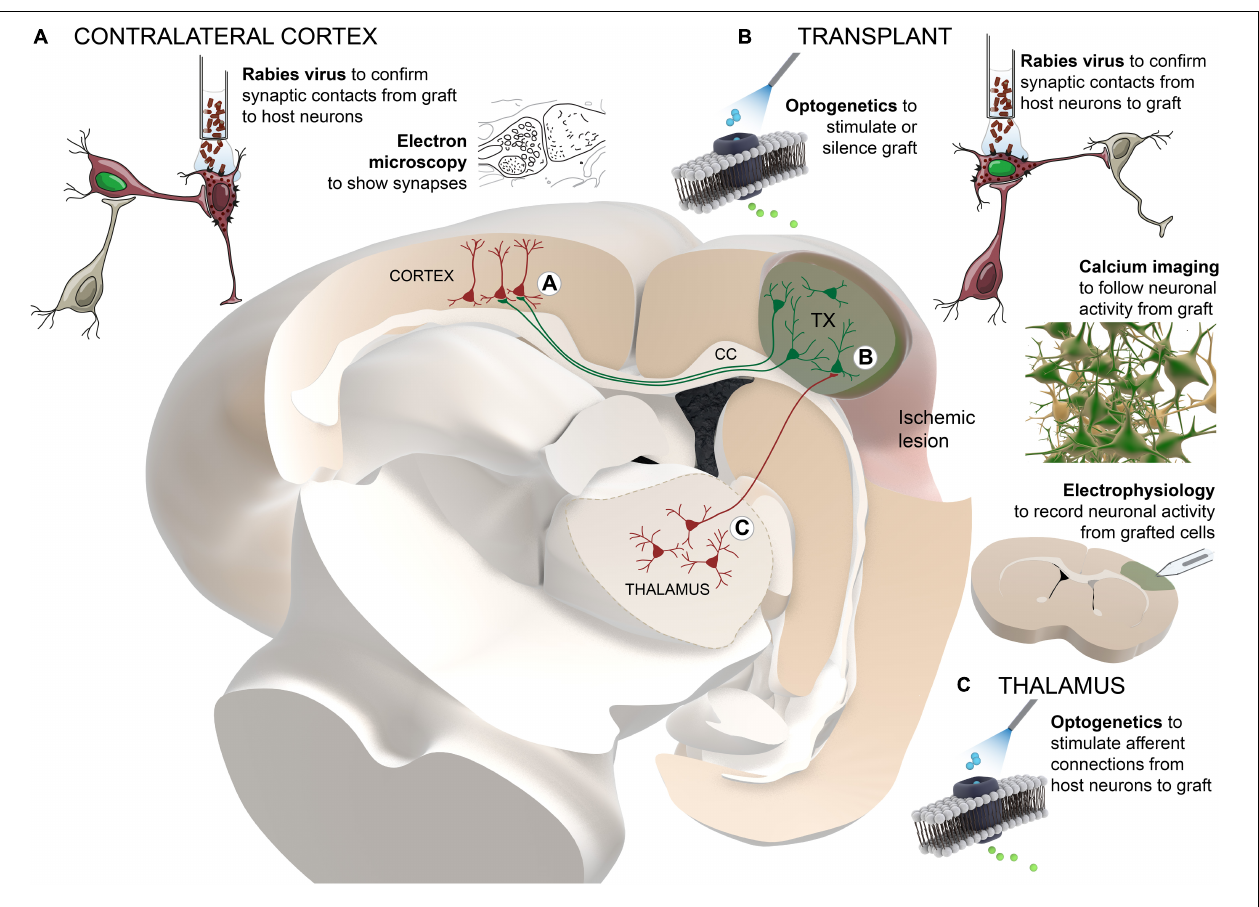
FIGURE 1 | Schematic summary of the technological approaches used to study the functional connectivity between grafted and host neurons. Transplanted cells (colored in green) are located adjacent to the cortical ischemic lesion. For clarity and as an example, thalamo-cortical afferent projections to the graft and transcallosal projections from graft to host cortical neurons in the contralateral hemisphere are presented. Different techniques are distributed in the areas of the brain where they are applied: (A) contralateral cortex, (B) transplant, (C) thalamus. TX, transplant; CC, corpus